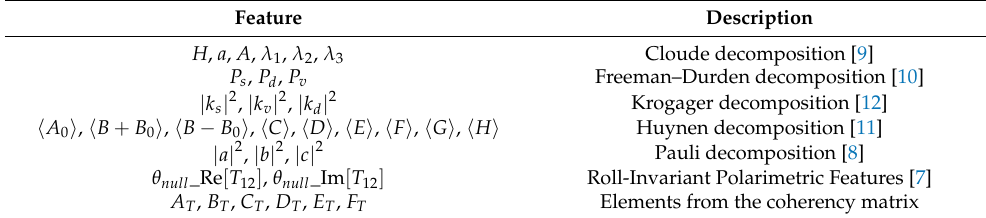
Table 1. PolSAR features used in this